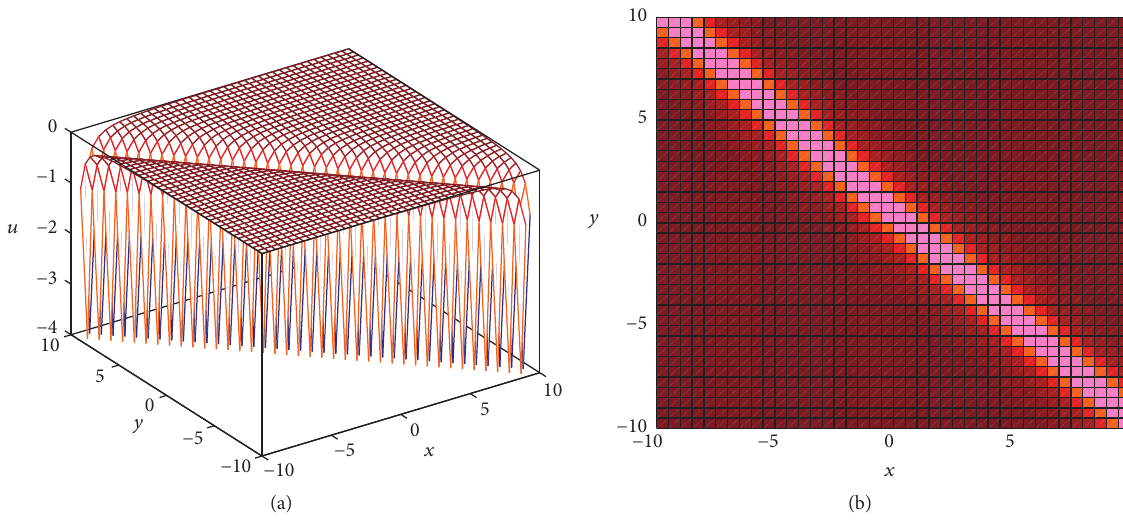
Figure 4: Pictures of (21): 3D plot (a) and density plot